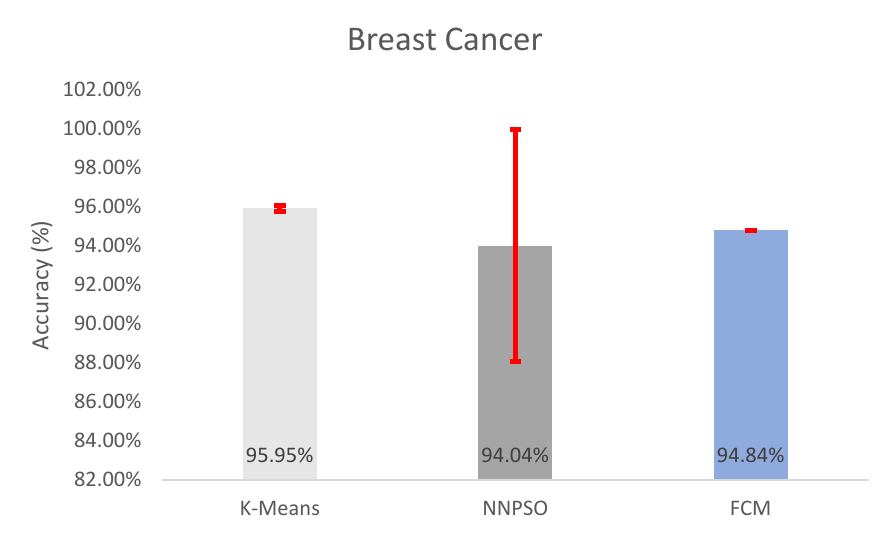
Figure 22. Accuracy of the algorithms on the Seeds dataset.